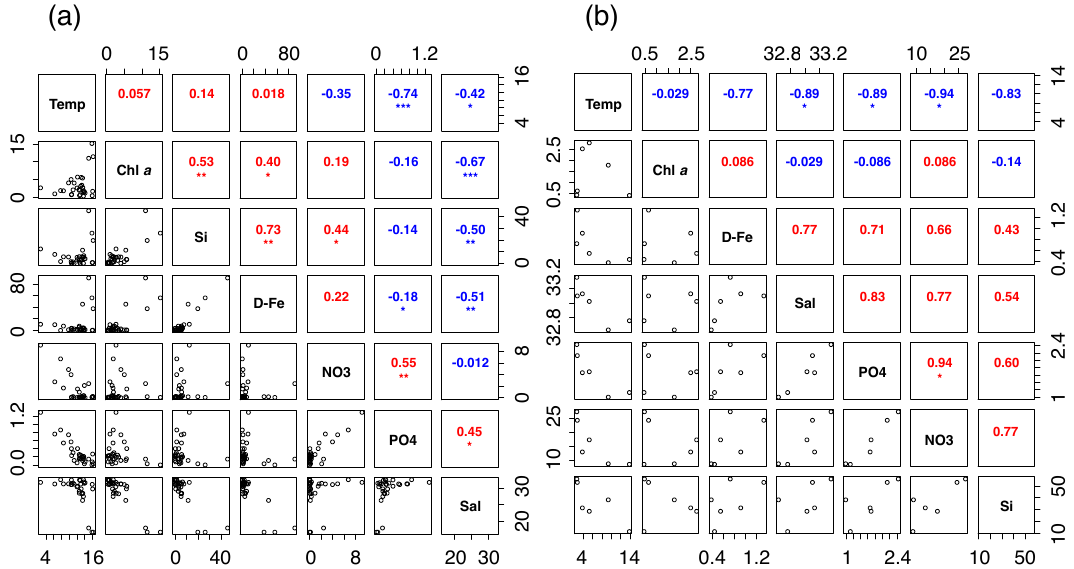
Fig. 2. Multi-panel display of pairwise relationships between the environmental variables, which are listed in Table 1: (a) off Sakhalin Island (Stns B1–G16) and (b) off the Kuril Islands (Stns UrupW–A4) with Spearman’s rank correlations ( ρ ). The Temp, Si, NO 3 , and Sal correspond to temperature, Si(OH) 4 , NO 3 + NO 2 , and salinity, respectively. The symbols ∗∗∗ , ∗∗ , and ∗ indicate the significance levels p < 0.001, < 0.01, and < 0.05,